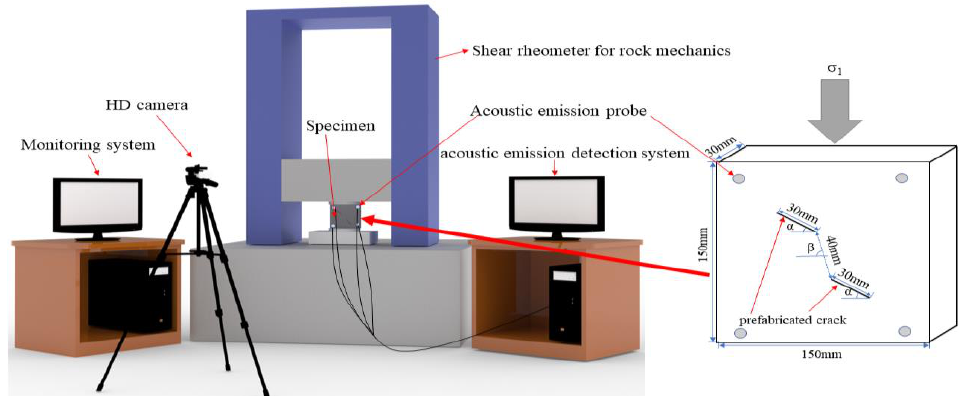
Figure 1. Rock mechanics test, acoustic emission system, and schematic diagram of prefabricated double fissure rock specimen.